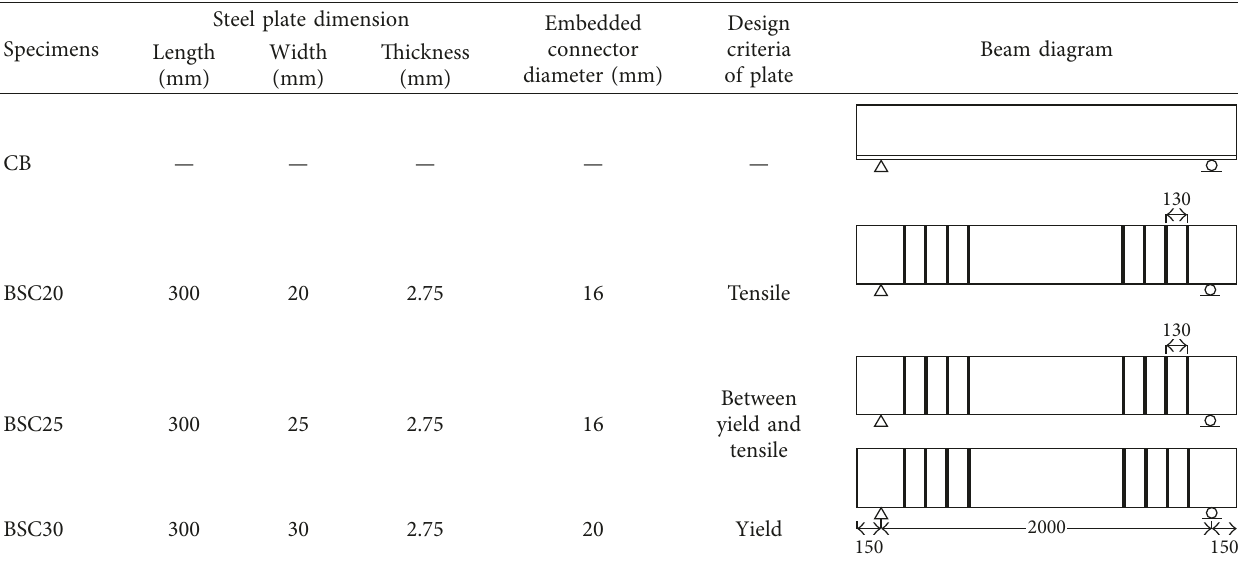
Table 1: Details of